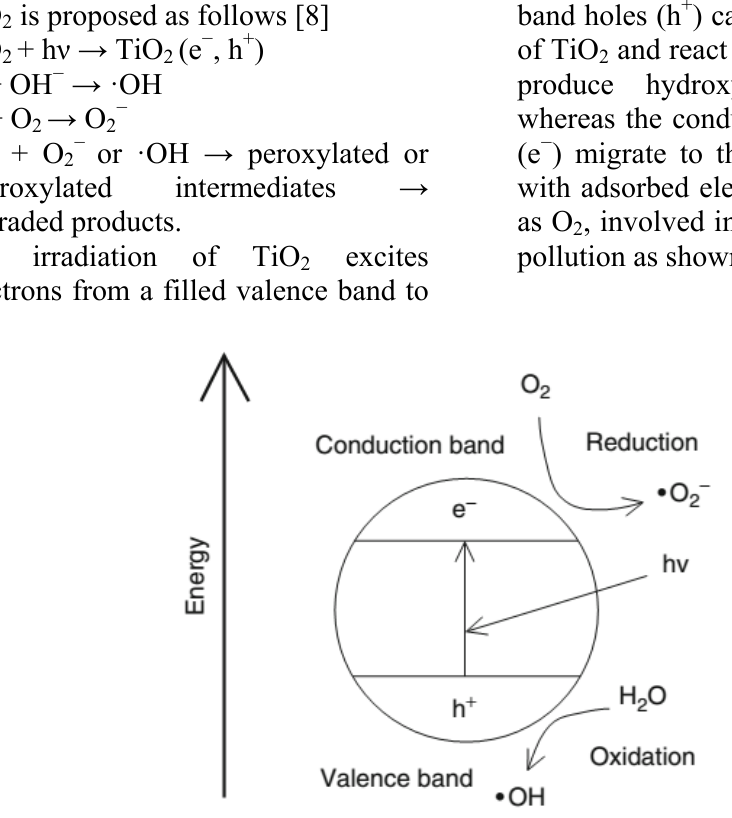
nanorods under U.V. 2